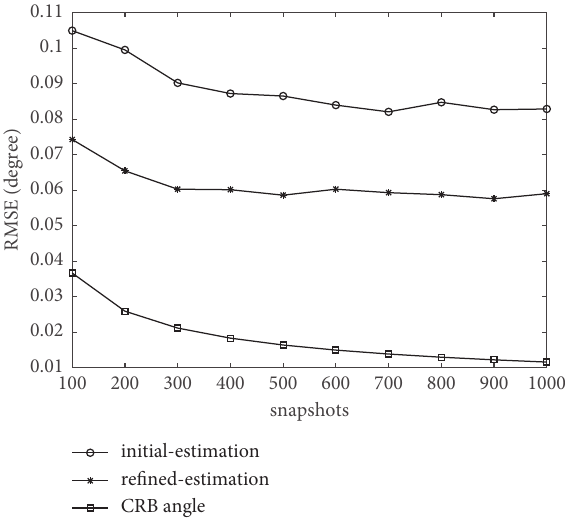
Figure 11: RMSE of DOA with different snapshots. 100 to 1000 with the step of 100.